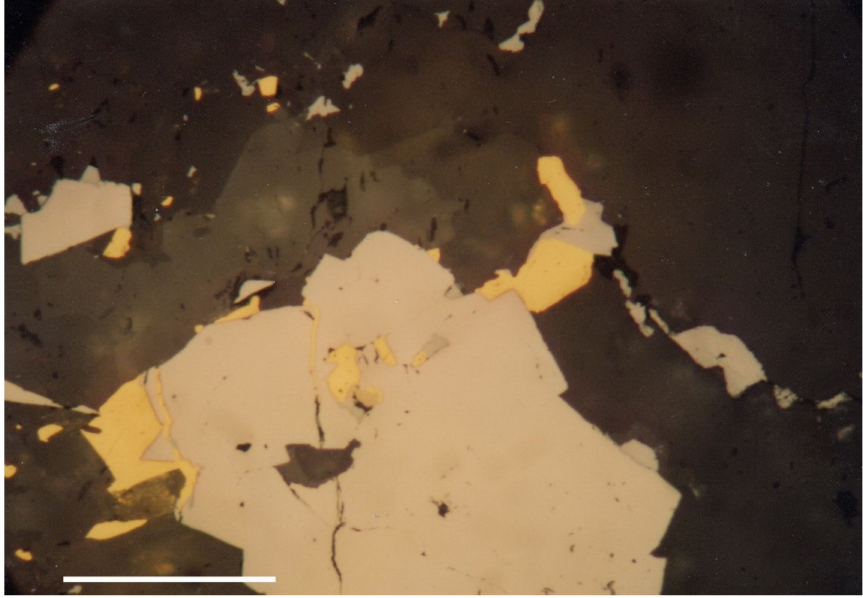
Figure 7. Strongly laminated quartz vein material from MIN1 comprising individual grains of arsenopyrite and coarse gold. Field of view: 0.7 mm; Scale bar 0.175